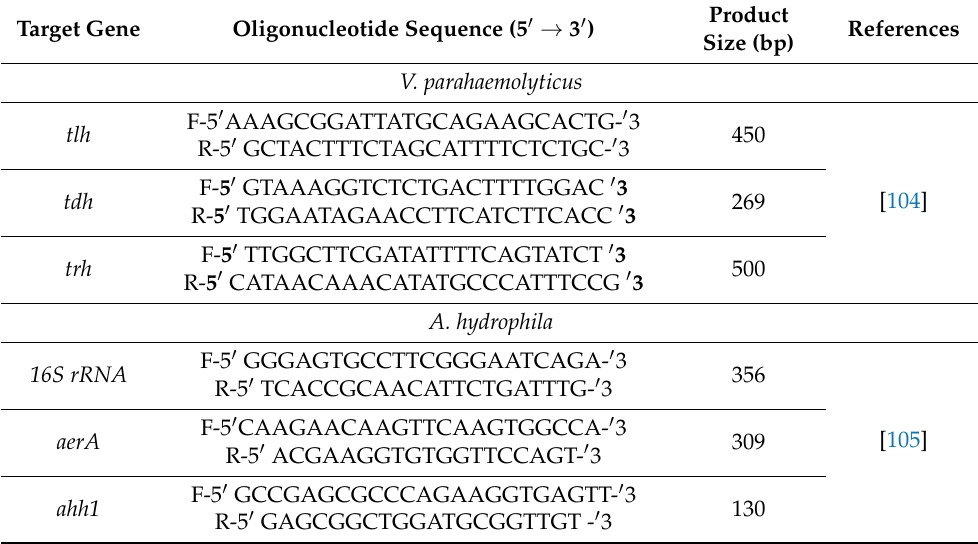
Table 6. Primer sets for PCR amplification of the target genes specific for V. parahaemolyticus and A. hydrophila